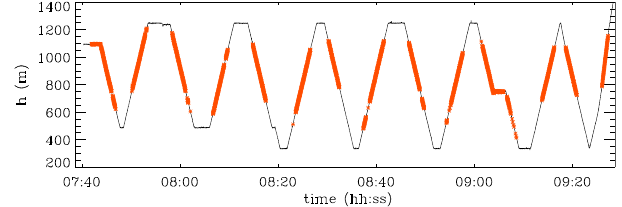
Fig. 2. Height of the aircraft ATR-42 as a function of time. Red color marks periods when aircraft encountered a